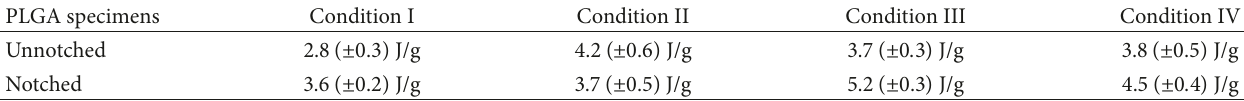
Table 3: Relaxation enthalpy values for PLGA specimens determined by